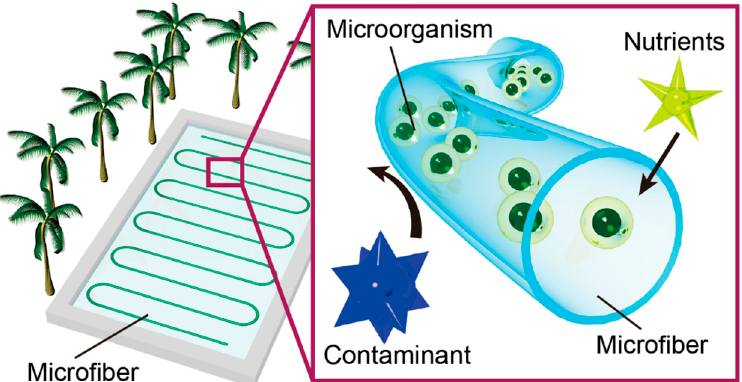
Figure 1. Conceptual schematic of the hollow hydrogel microfiber containing microorganisms in an open cultivation system. The pore size of the hydrogel allows nutrients to pass through the fiber but prevents contaminants from entering the fiber.